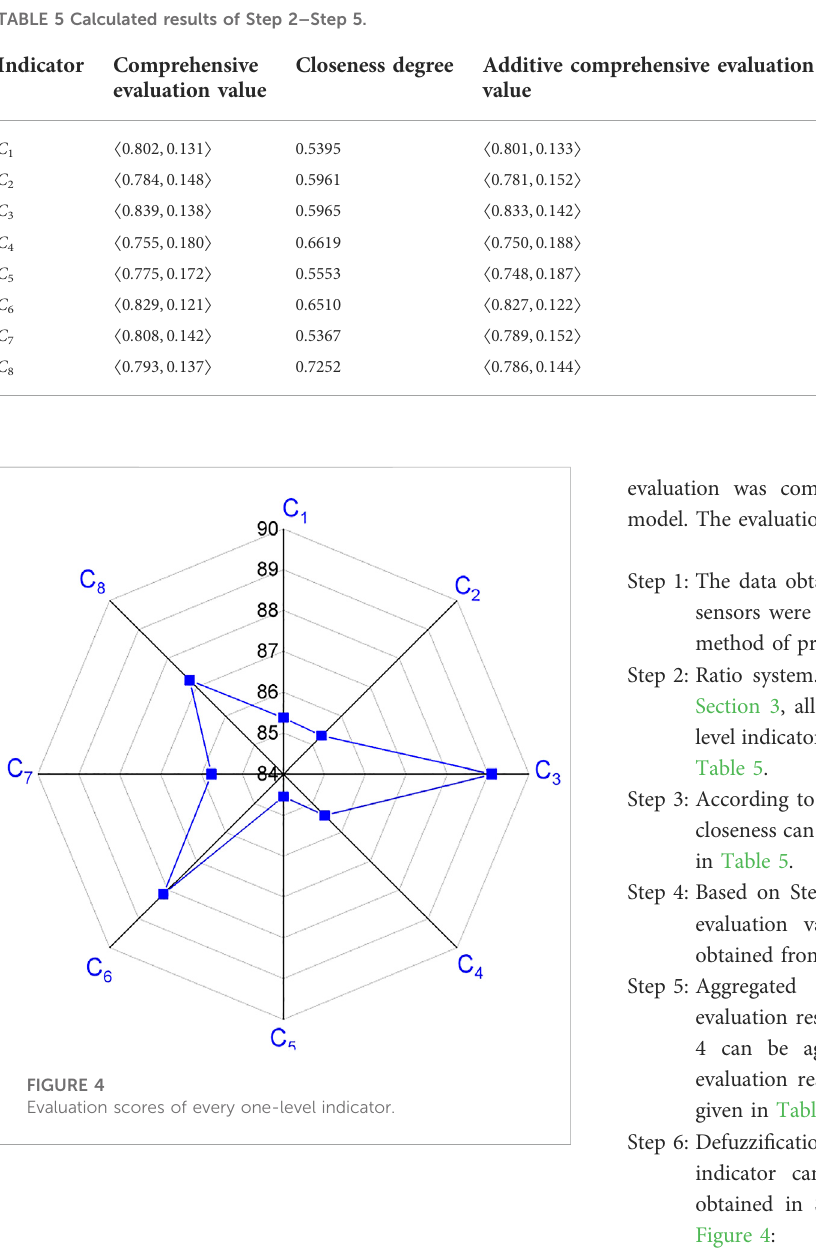
evaluation information of every two-level indicator are shown in Table 3. 2) Calculation of indicators ’ weights From the weighting method of indicators, the weights of every one-level and two-level indicator are given in Figure 3 and Table 4.